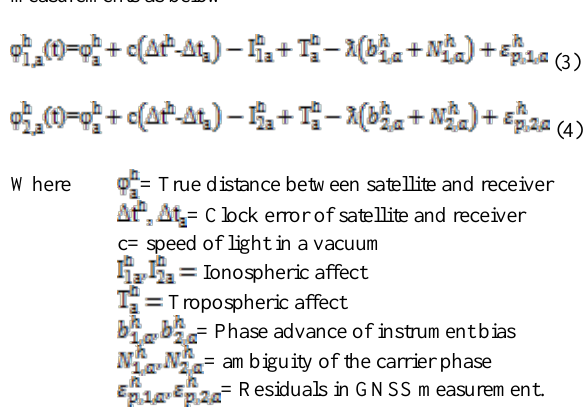
Figure 2. TEC values derived from GPS, IRI and GIM are produced with two hours increments from eighth day to fifteenth day in January, April, July and October